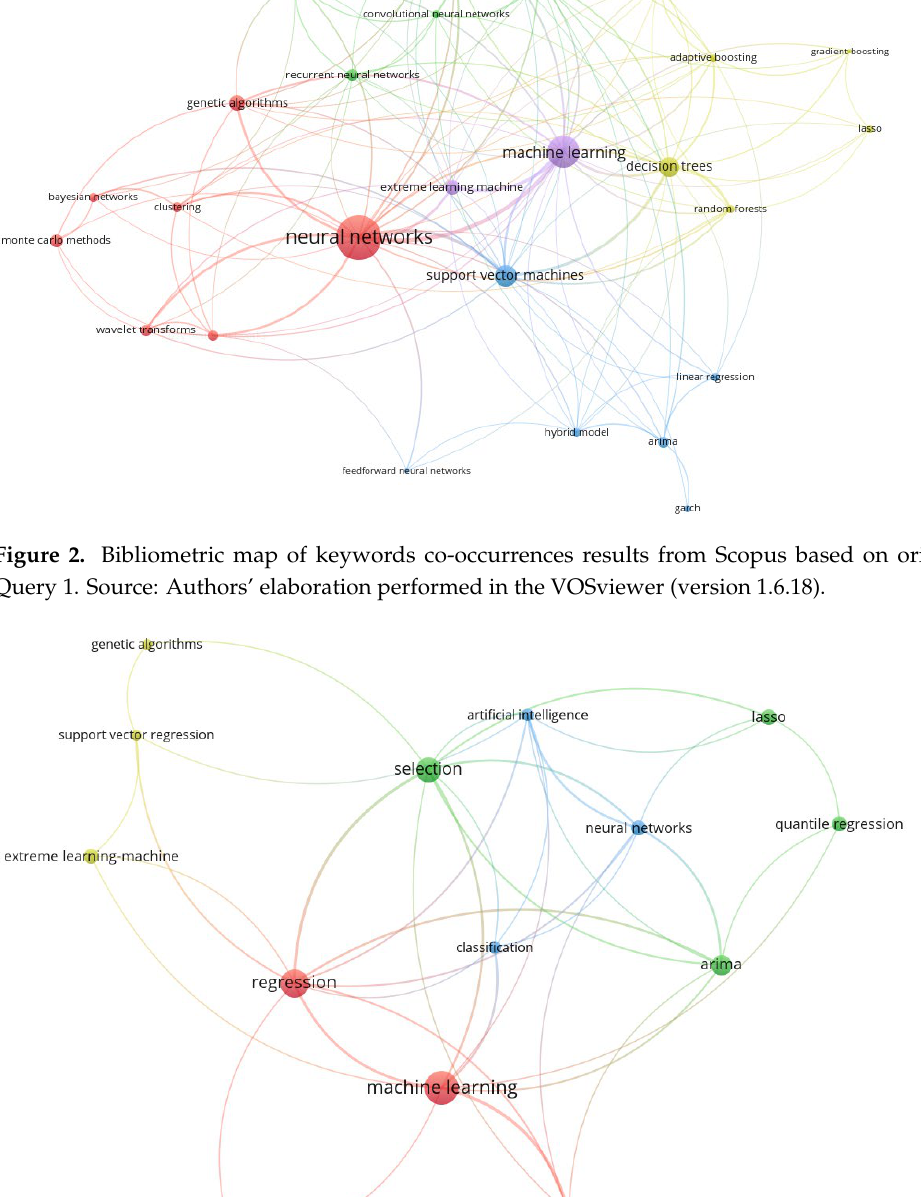
Table 2. Clusters of keywords co-occurrences visible in Figure 2 for Scopus.